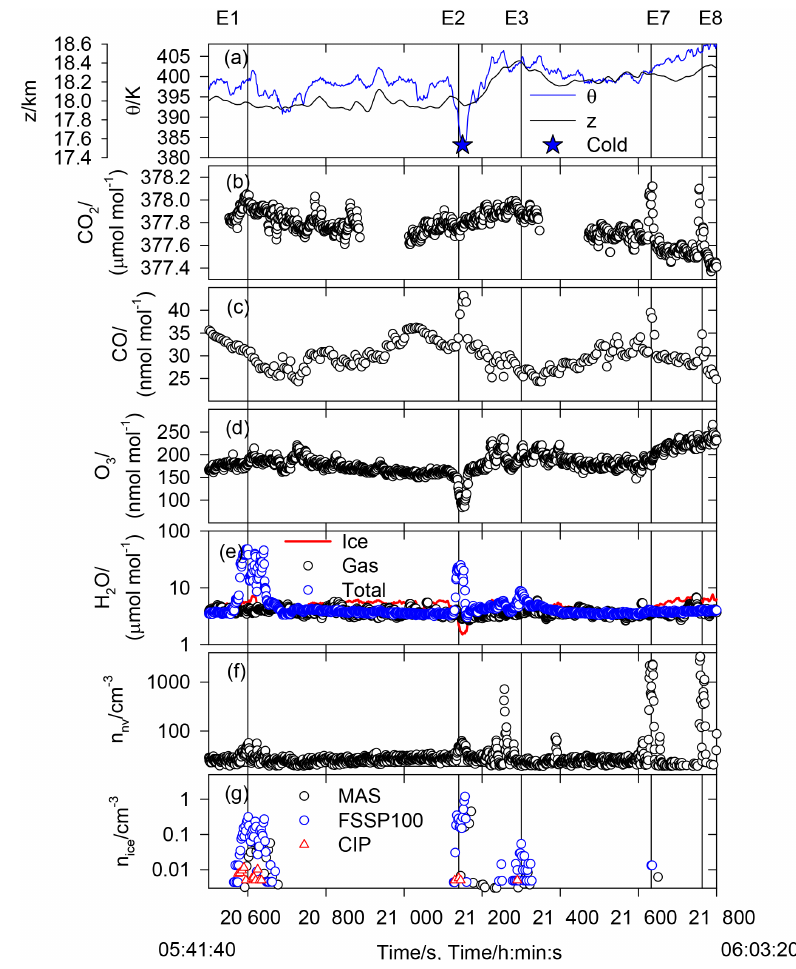
Figure 9. Measurement results versus time for the time period containing events E1, E2, E3, E7, and E8 (with event times indicated by vertical lines). (a) 1Hz data for geometric altitude z and potential temperature θ , with identification of the minimum temperature (“cold”). (b) Molar mixing ratios of carbon dioxide CO 2 , (c) carbon monoxide CO, (d) ozone O 3 , and (e) water vapor H 2 O, for ice-saturation (red line), gas phase (black circle), and total water (blue circle). (f) Nonvolatile particle concentration and (g) ice particle concentrations as derived from MAS backscatter (black), FSSP100 (blue), and CIP